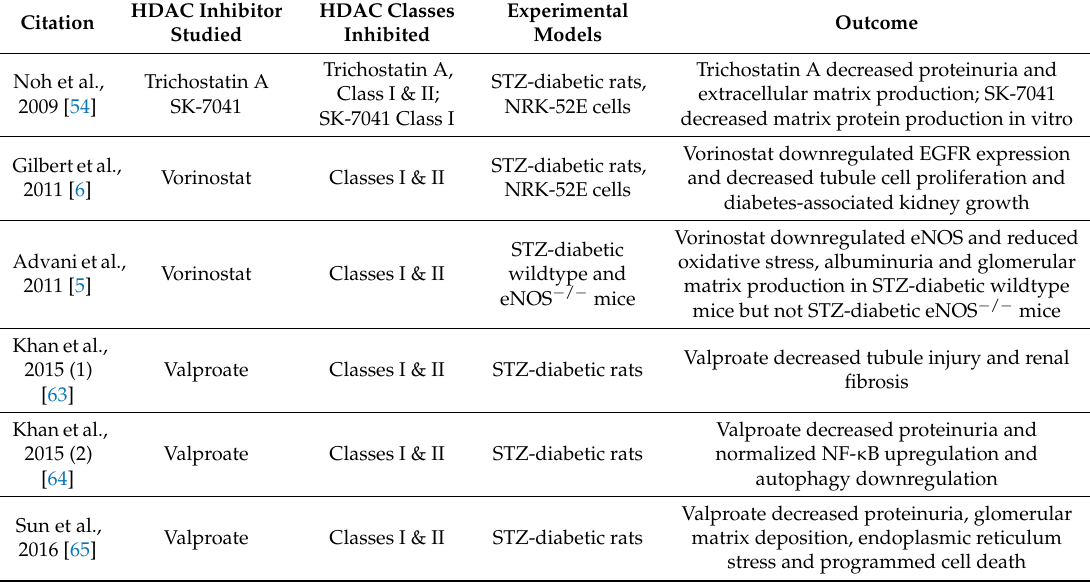
Table 2. Articles reporting the effects of pharmacological HDAC inhibitors in experimental diabetic kidney